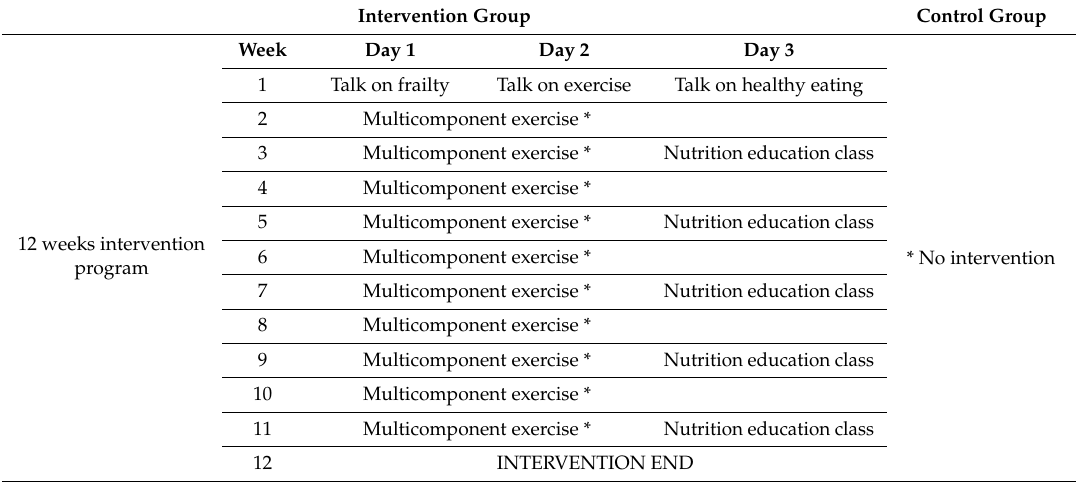
Table 2. Summary of the frailty FINE